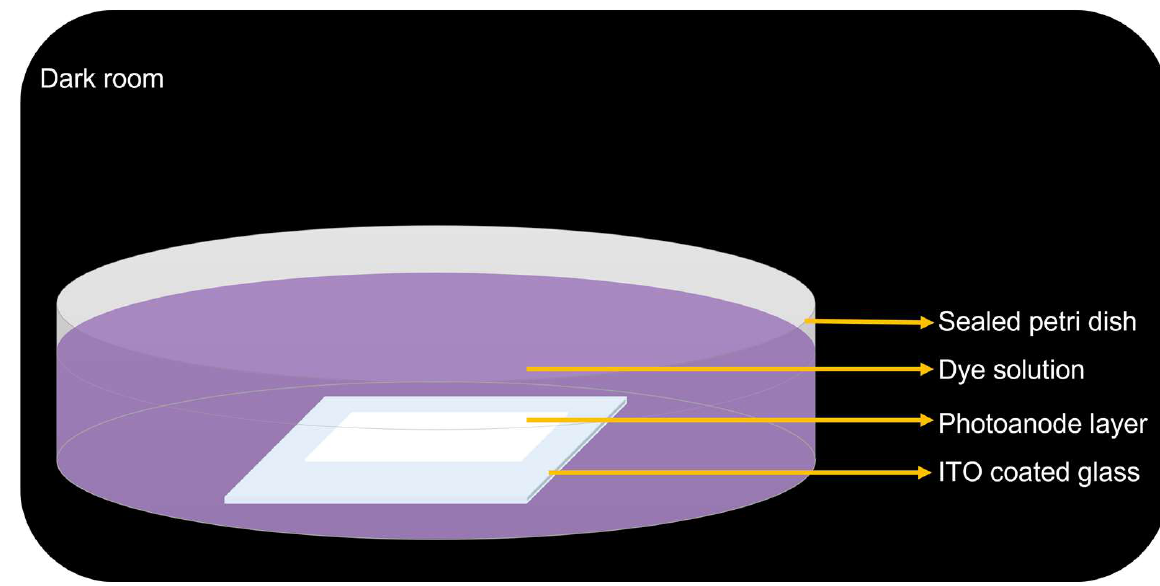
Figure 4. Photoanode dye coating process in dark ambient.